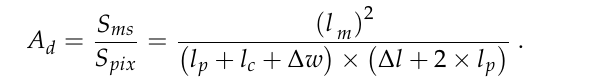
Figure 7. ( a ) The process of rising temperature. ( b ) The simulated photothermal responsivity of metasurface absorber.